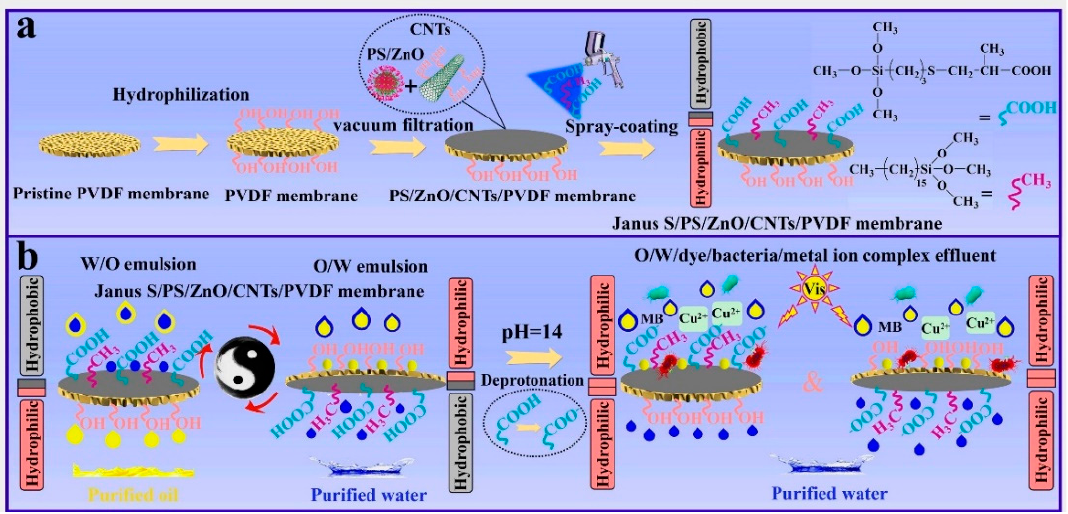
Figure 8. ( a ) Schematic for the preparation process of the Janus S/PS/ZnO/CNTs/PVDF composite membrane and ( b ) its use for membrane separation of surfactant-stabilized W/O and O/W emulsions and O/W/dye/bacteria/metal-ion-complex wastewater. Reprint with permission from Ref. [76]. Copyright 2022, Elsevier.